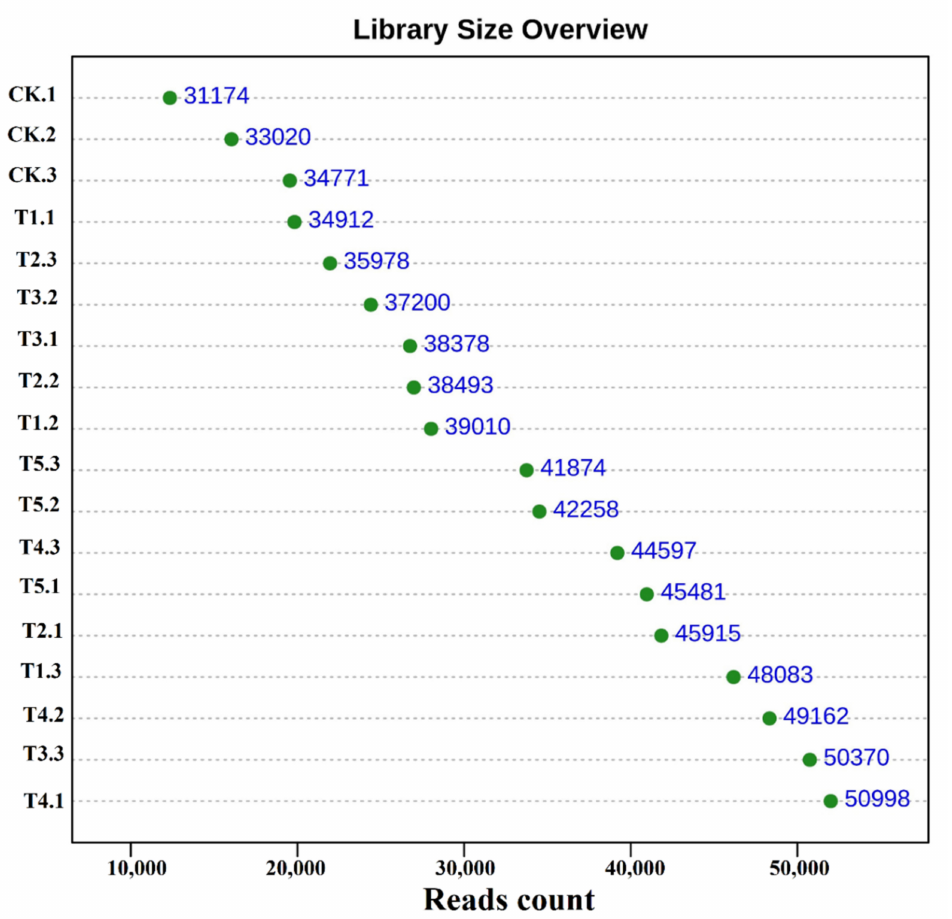
Figure 1. Library size overview of all the samples as influenced by various biochar application